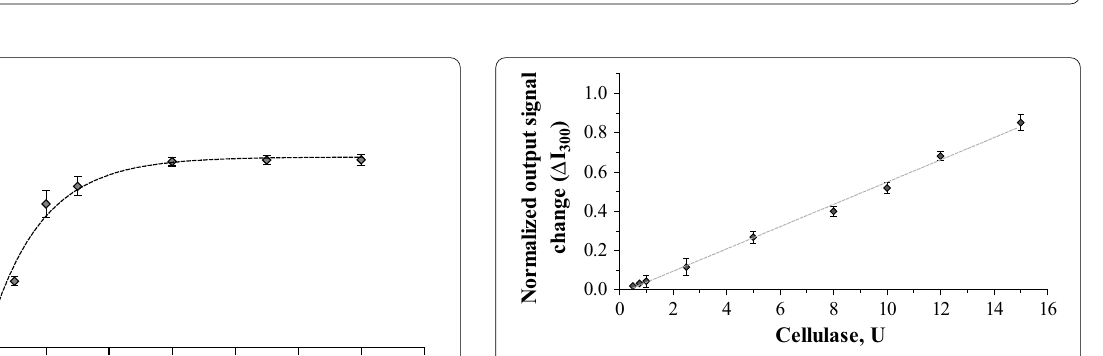
Fig. 5 Calibration plot: for the assessment of cellulase activity. All measurements were carried out in air-saturated 1% CMC solution in 0.1 M acetate buffer (pH 5.0) at constant stirring at 25 °C. Experimental conditions: CMC was incubated with cellulase for 70 min; glucose oxidase concentration was 12 U/ml; measurement time was 300